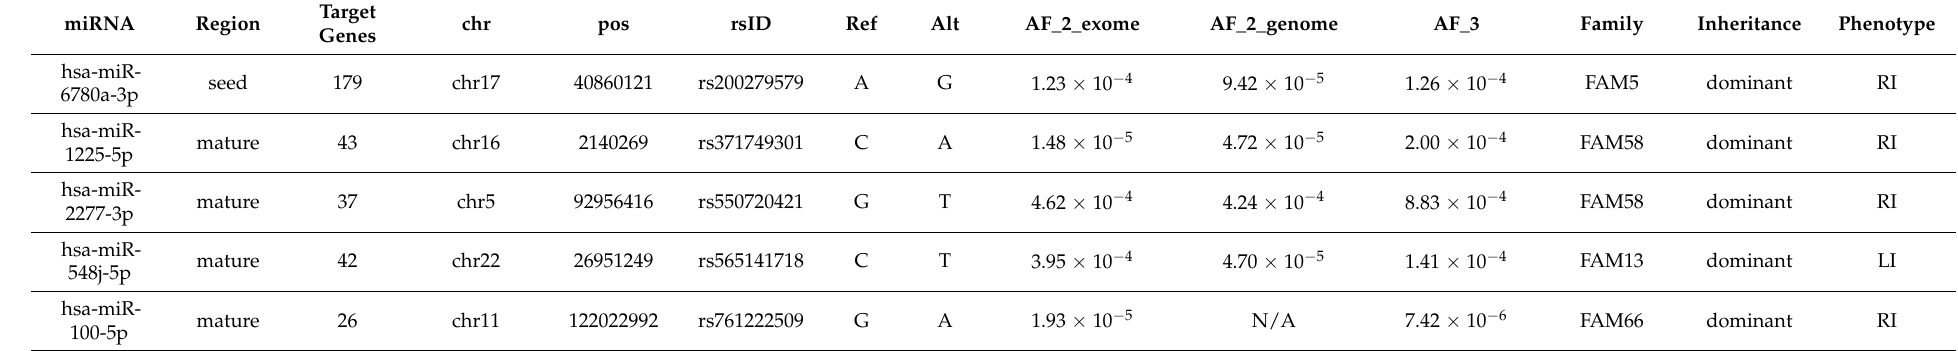
Table 2. miRNA candidate